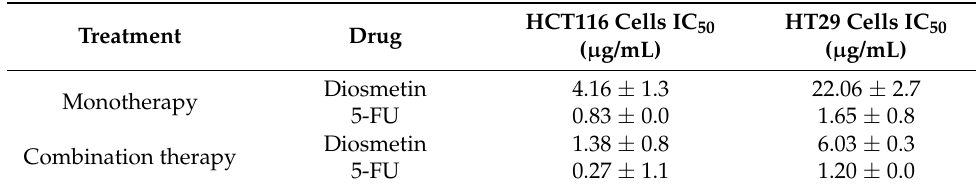
Figure 3. Cell growth inhibitory effect of diosmetin (D) and 5-FU as monotherapy and combination therapy in HCT116 cells. Data were expressed as mean ± standard deviation (SD). * p < 0.05 and ** p < 0.01 indicate significant differences compared to the untreated control (0). Table 1. IC 50 of diosmetin and 5-FU as monotherapy or combination therapy in HCT116 and HT29 cells.